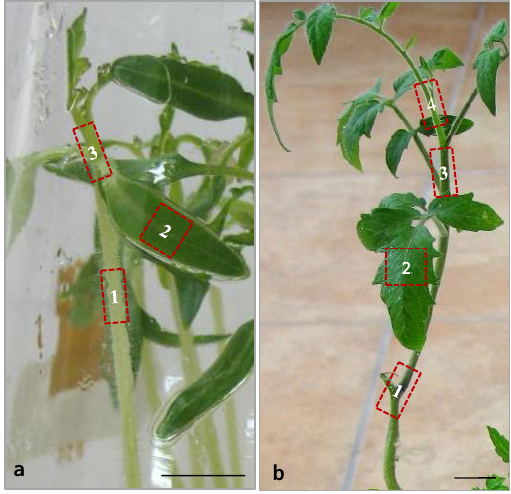
Figure 3. Explants used for in vitro regeneration experiments. ( a ) 1—hypocotyl; 2—cotyledon; 3—cotyledonary node; ( b ) 1—stem node; 2—leaf explant; 3—internode; 4—apical bud. Bars 1 cm.